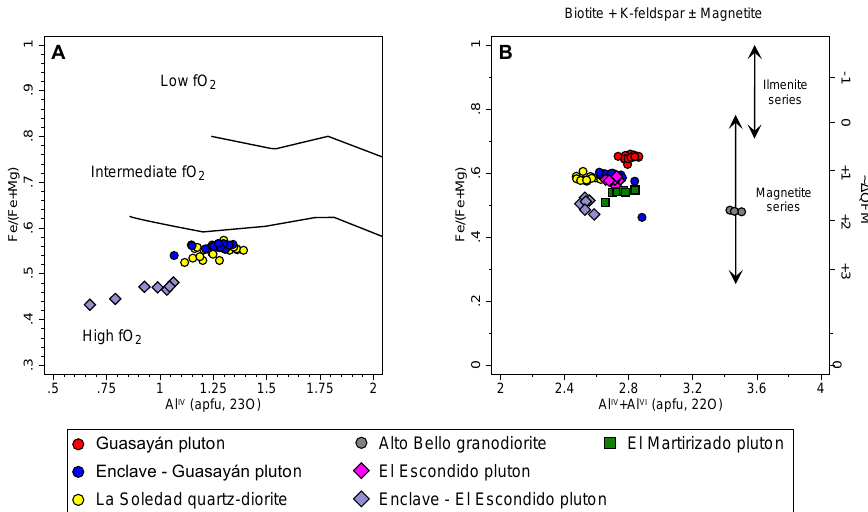
Figure 7. Oxygen fugacity estimation for the granitoids from the Sierra de Guasyaán. ( A ) Fe/(Fe + Mg) vs. Al IV diagram for amphibole. Compositional fields after [25] ( B ) Fe/(Fe + Mg) vs. Al IV + Al VI for biotite. Ilmenite and magnetite series after [27].